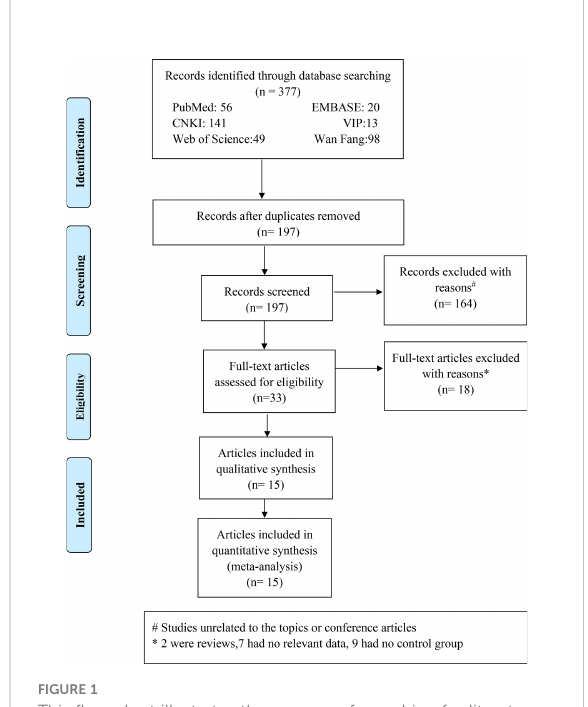
FIGURE 1 This fl ow chart illustrates the process of searching for literature and selecting